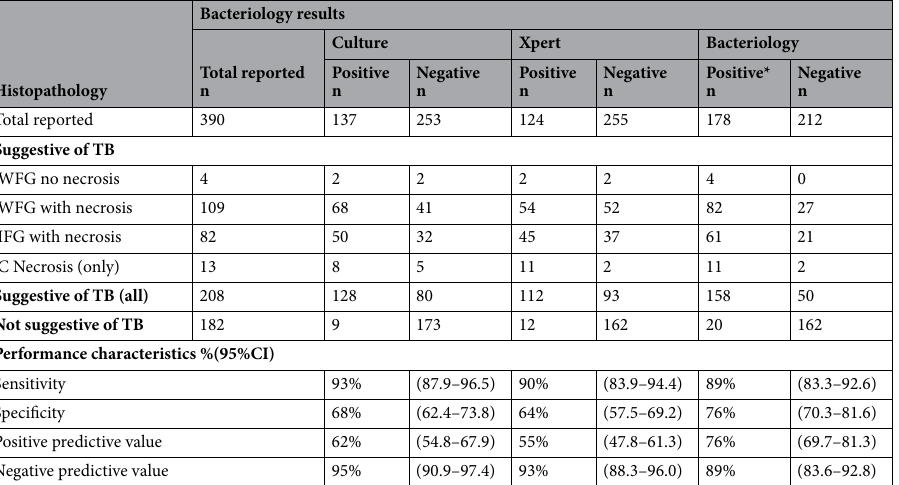
Table 3. Performance of histological examination against culture, Xpert MTB/Rif assay, and bacteriology in the diagnosis of tuberculous lymphadenitis. HP: Histopathology, WFG: Well-formed granuloma, IFG: Ill- formed granuloma, C. Necrosis: Caseous necrosis, TB: tuberculosis. *Bacteriology positive defined as positive on Xpert and/or